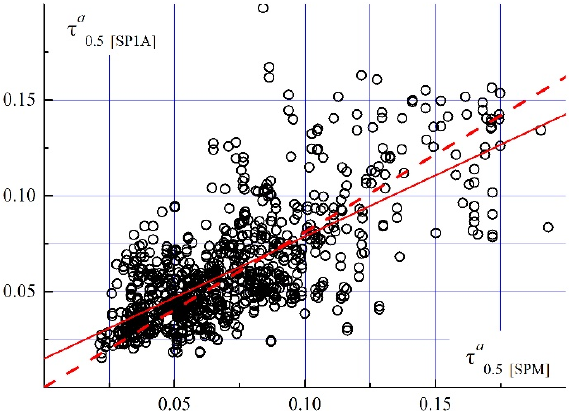
Figure 1. Scatter diagram of AOD measurements in two regions us- ing SP1A (Ny-Ålesund) and SPM (Barentsburg) photometers. The solid line shows the unconstrained linear regression, and the dotted line shows the regression through the origin